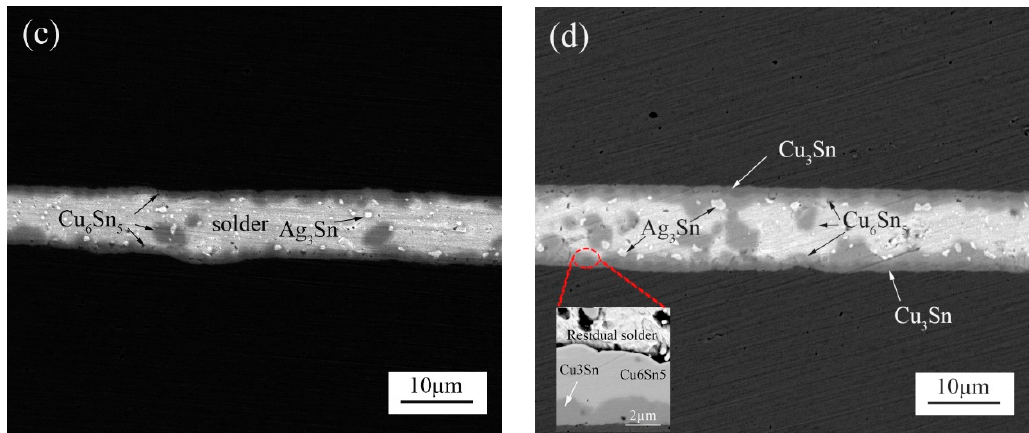
Figure 3. The morphologies of the cross-sectional Cu/SAC305/Cu joints formed at an 800-ms ultrasonic bonding time at different aging times of ( a ) 0 h; ( b ) 120 h; ( c ) 240 h and ( d ) 360 h. The inset in (d): the local enlargement image at the interfaces. Table 1. The EDS analysis.